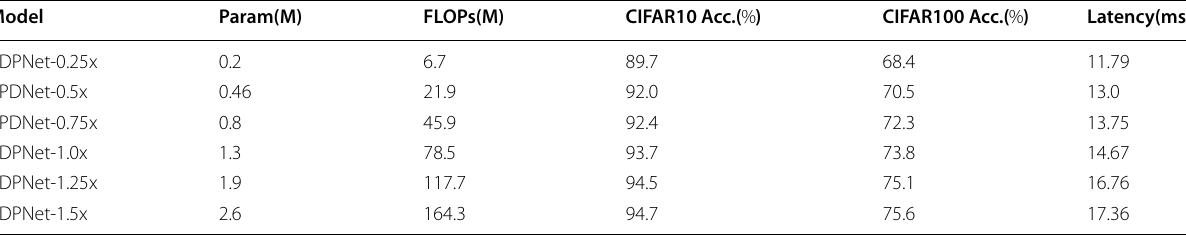
Table 4 Comparison of RDPNet and MobileNet series on CIFAR10/100 Model